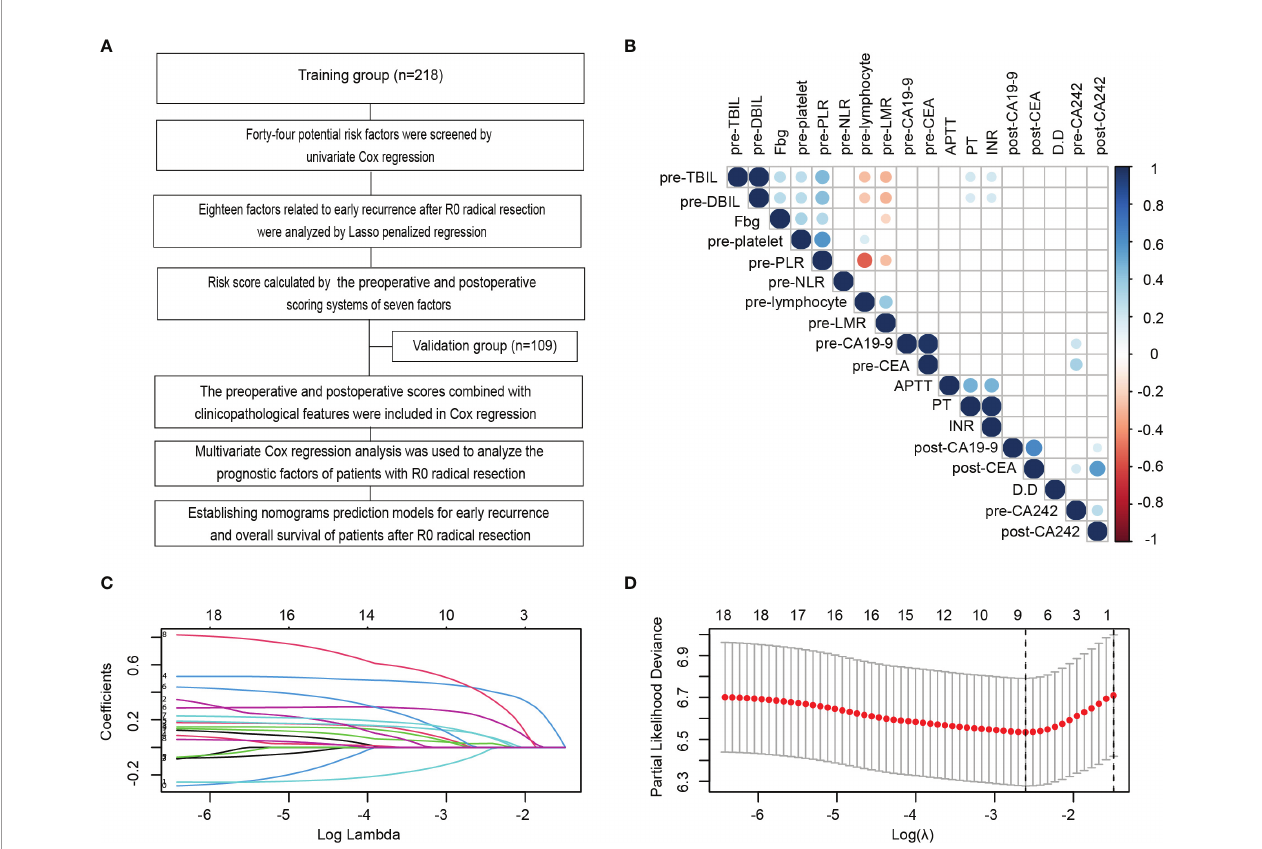
FIGURE 1 | Identi fi cation and establishment of scoring systems related to serum indexes for early recurrence during the perioperative period. (A) Flowchart of the establishment of scoring systems and nomograms for the early recurrence and long-term prognosis of PDAC patients after radical resection in this study. (B) Correlation analysis amongst 18 variables with p values less than 0.05 in the univariate Cox analysis of the training cohort. (C, D) LASSO analysis of the 18 variables with p < 0.05 in the univariate Cox regression analysis to screen out the perioperative serological factors that affect the early recurrence of PDAC patients with radical resection in the training cohort. Shrinkage coef fi cient diagram was shown in (C) . Each curve represented the change track of each candidate variable coef fi cient. As the value of l increased, the greater the degree of model compressed, the less the number of candidate variables entered the model. Ten-fold cross-validation diagram showed the determination of the best l Value (D)